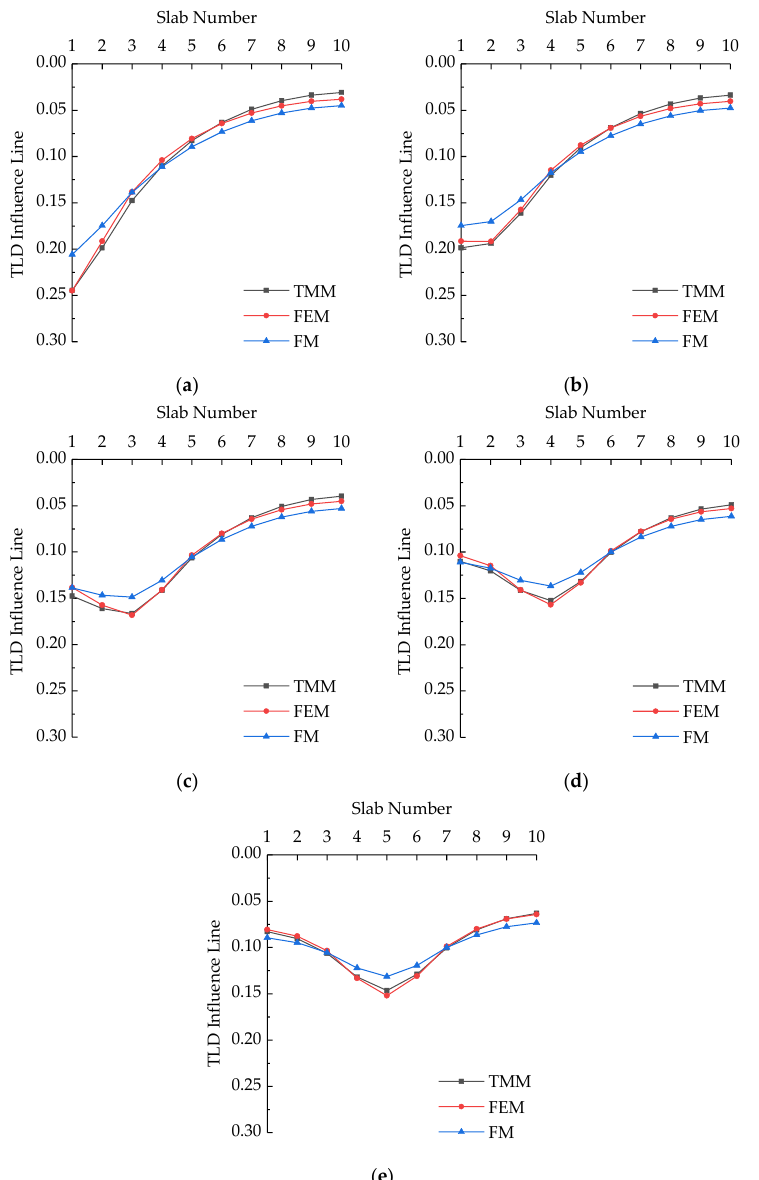
Figure 11. The TLD influence lines of each slab in the L /8 span: ( a ) slab 1; ( b ) slab 2; ( c ) slab 3; ( d ) slab 4; ( e ) slab 5.